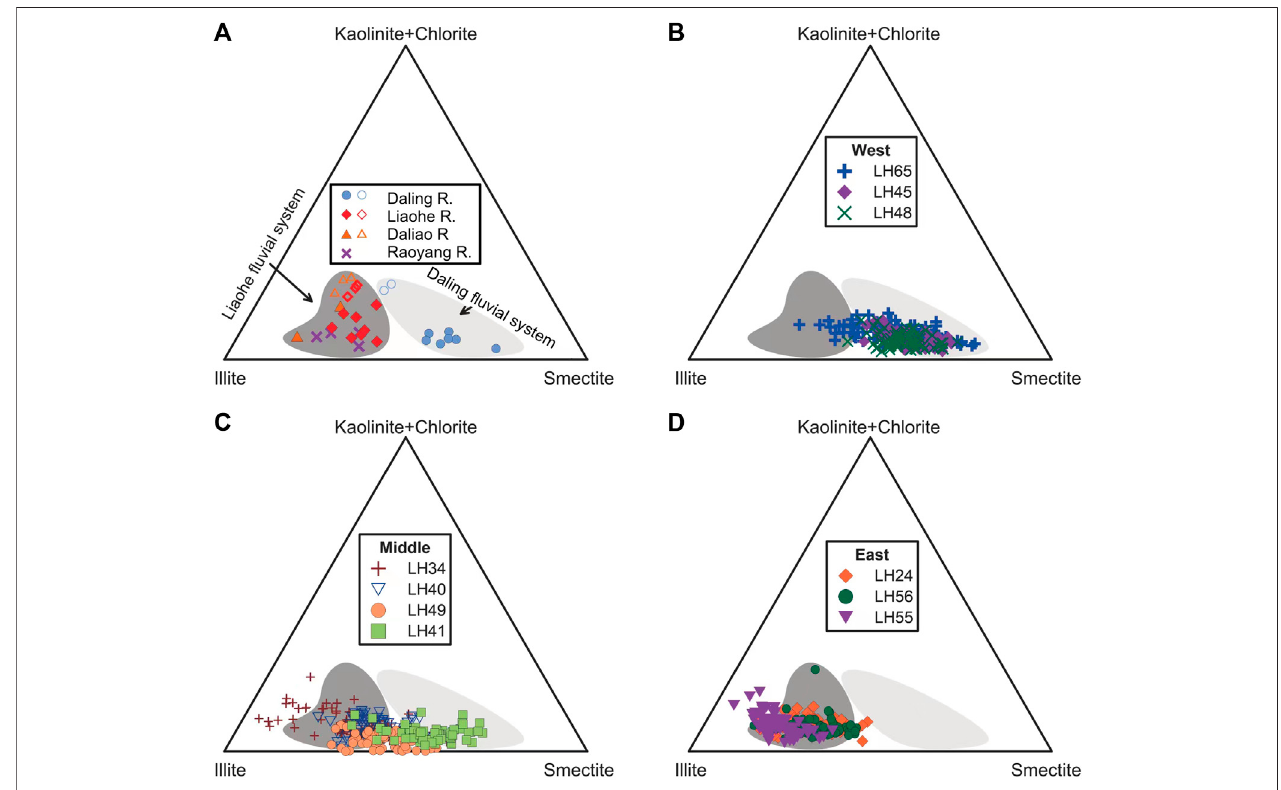
FIGURE 7 | Ternary diagrams of the major clay mineral groups: kaolinite + chlorite, illite, and smectite for the (A) modern riverine sediments, and core sediments from the west (B) , middle (C), and east (D) of the study area.